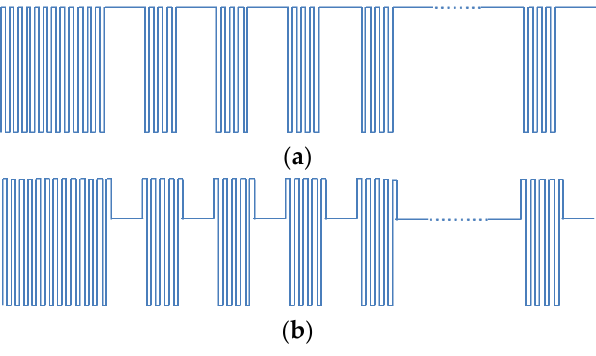
Figure 13. Intra-frame flickering compensation. ( a ) Signal without dimming; ( b ) Signal with dimming applied to the logic zero bits.